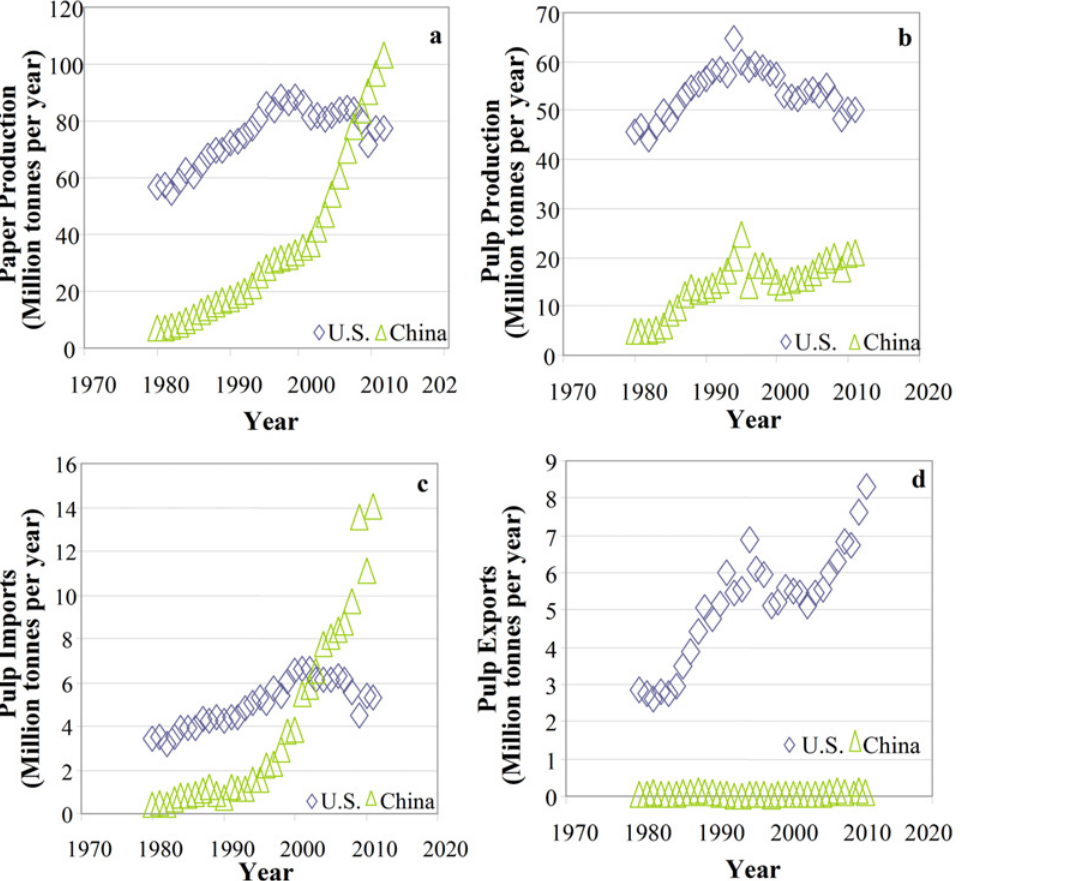
Fig 1. Historical pulp and paper trends for the U.S. and